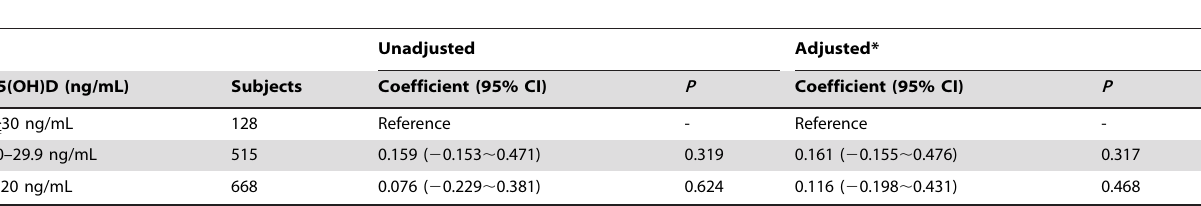
Table 5. Association of serum 25(OH)D status with total immunoglobulin E